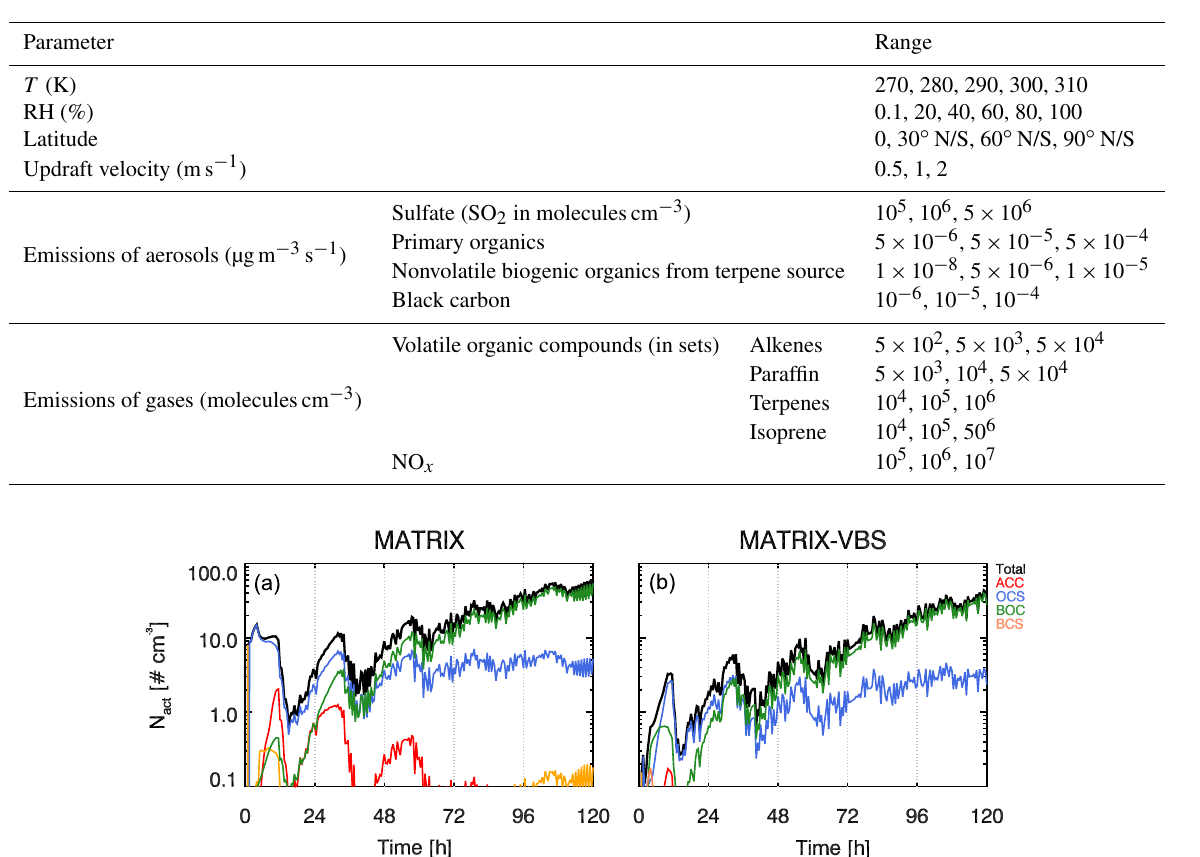
Table 2. Parameters used in the Monte Carlo simulations.